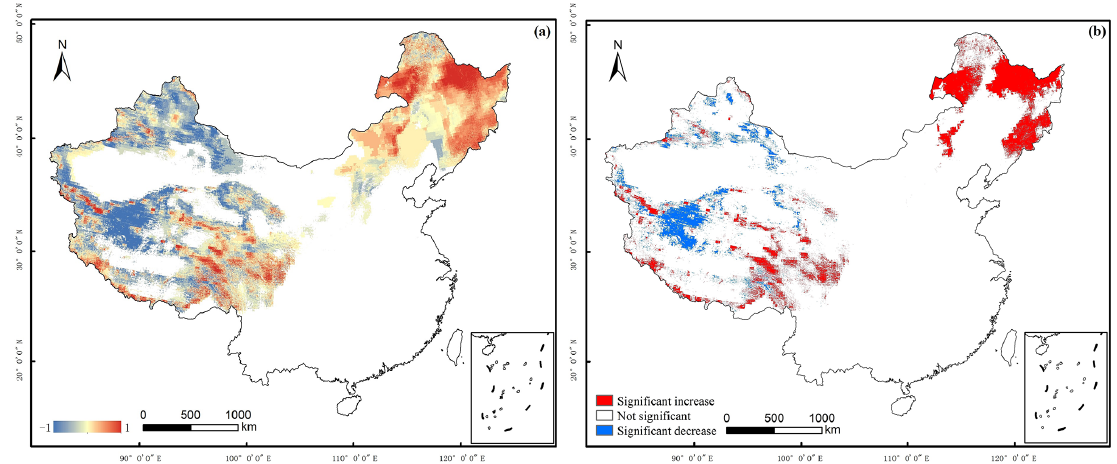
Figure 9. Variation in the average annual SD in China based on the Mann–Kendall method between 2001 and 2014. (a) Variation in the average annual SD; (b) significance of the variation in the average annual SD.